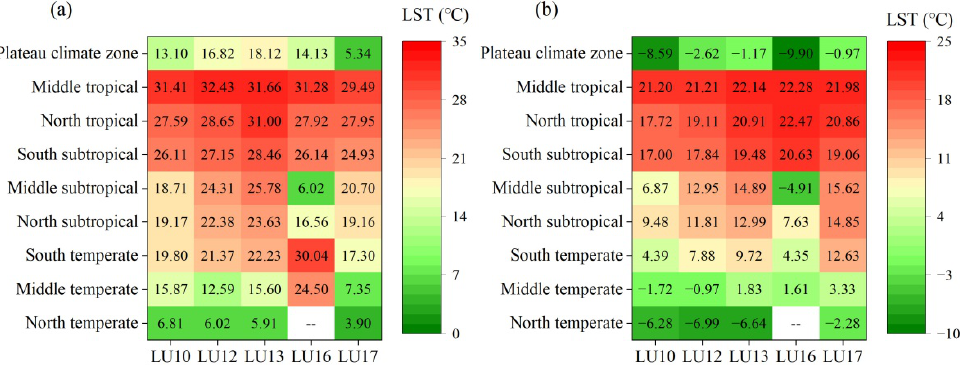
Figure 5. Distribution map of mean daytime and nighttime annual land surface temperature (LST) in different land use/land cover (LULC) types in different climate zones of China. LU10, LU12, LU13, LU16, and LU17 represent grasslands, croplands, urban and built-up lands, barren land, and water bodies, respectively. ( a ) Daytime; ( b ) nighttime.